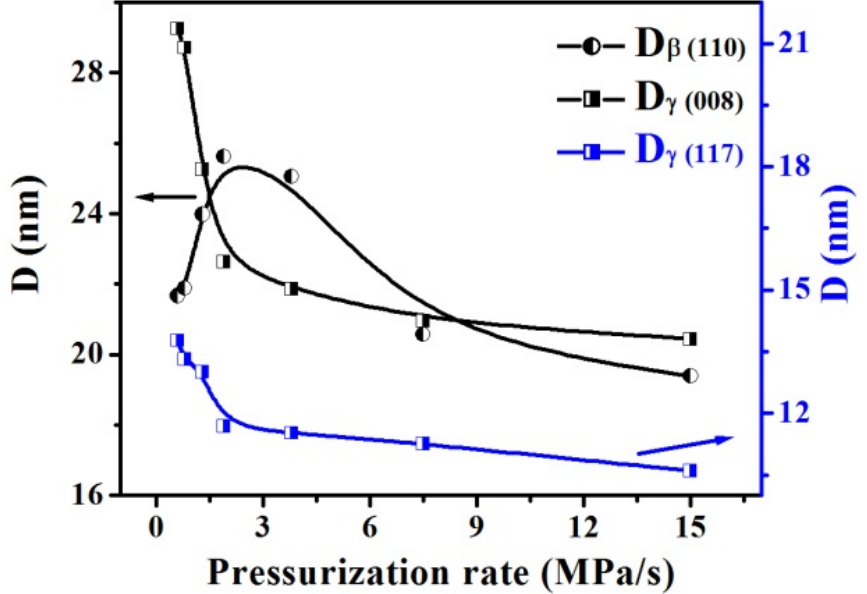
Figure 4. Changes in the crystallite size D for β and γ crystal as a function of pressurization rates. SAXS was used to obtain the lamellae information. Figure 5a shows the Lorentz- corrected intensity plots as a function of scattering vector ( q = 4 π sin θ / λ ). For the iPP0.2 sample treated at a rate of 0.6 MPa/s, two scattering peaks named q 1 and q 2 of 0.32 and 0.59 nm − 1 were observed, which are close to that of pure β and γ crystal of iPP, respectively (Figure 5b). Figure 5c summarized the change trend of the maximum intensity ( I max ) of the scattering peaks. With the increasing pressurization rate, the I max of the first peak adds in the early stage until it reaches R 1 , and then decreases observably, consistent with the change trend of β -iPP crystallinity (Figure 3d). Similarly, the I max of the second peak decreases with the pressurization rate increase, analogous to the change trend of γ -iPP content. Thereby, we attribute the first and second scattering peak to β - and γ -iPP lamellae stacks, respectively. Figure 5c also shows the evolution of relative long period L that is determined by using the Bragg law. The crystallized samples seem to have two divided long-period peaks, demonstrating that the crystals of β - and γ -iPP are present in the respective lamellae within different spherulites. It displays that when the pressurization rate increases from 0.6 MPa/s to R 1 , L of β crystal decreases slightly from about 19.0 to 18.0 nm, while the L of the γ crystal decreases remarkably from about 13.0 to 10.5 nm. The decrease in L corresponds to the decrease in lamellae thickness, meaning the small increase in the pressurization rate can suppress the growth of lamellae, and this inhibition effect in γ crystal seems more pronounced than that in β crystal. This behavior is consistent with the